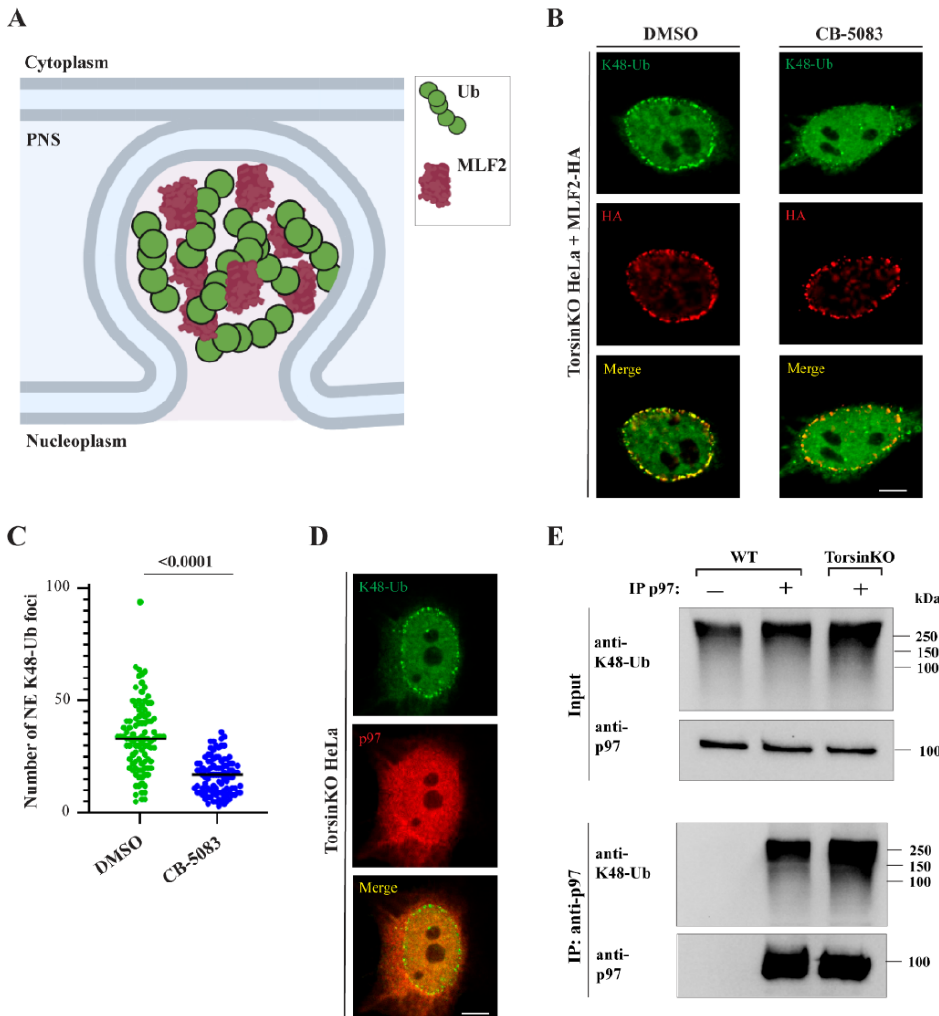
Figure 1. K48 ‐ Ub accumulation inside NE blebs of Torsin ‐ deficient cells requires p97 activity. ( A ) Schematic diagram of a NE bleb. PNS, perinuclear space. Ub, ubiquitin. ( B ) Representative immunofluorescence (IF) images of TorsinKO HeLa cells overexpressing MLF2 ‐ HA under vehicle (DMSO) or p97 inhibition (CB ‐ 5083) conditions. Cells were treated with 5 μ M CB ‐ 5083 for four hours before processing for IF, stained with K48 ‐ Ub and HA antibodies, and imaged by confocal microscopy. Scale bar, 5 μ m. ( C ) The number of NE ‐ associated K48 ‐ Ub foci in TorsinKO cells upon DMSO or CB ‐ 5083 treatment was quantified for 100 cells/condition. Statistical analysis was performed using a Mann–Whitney U test. ( D ) Representative IF image of p97 localization in TorsinKO cells. Cells were processed for IF and stained with p97 and K48 ‐ Ub antibodies. Scale bar, 5 μ m. ( E ) An immunoprecipitation (IP) of endogenous p97 under native conditions from WT and TorsinKO cells. The IP was analyzed by immunoblot with antibodies against p97 and K48 ‐ Ub.